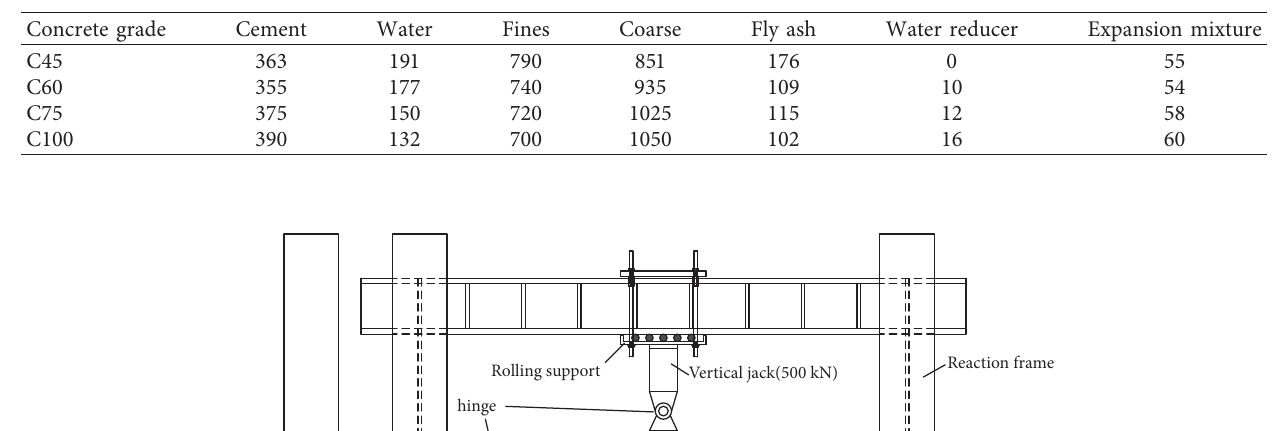
Table 2: Mix proportions of the concrete (kg/m 3 ).